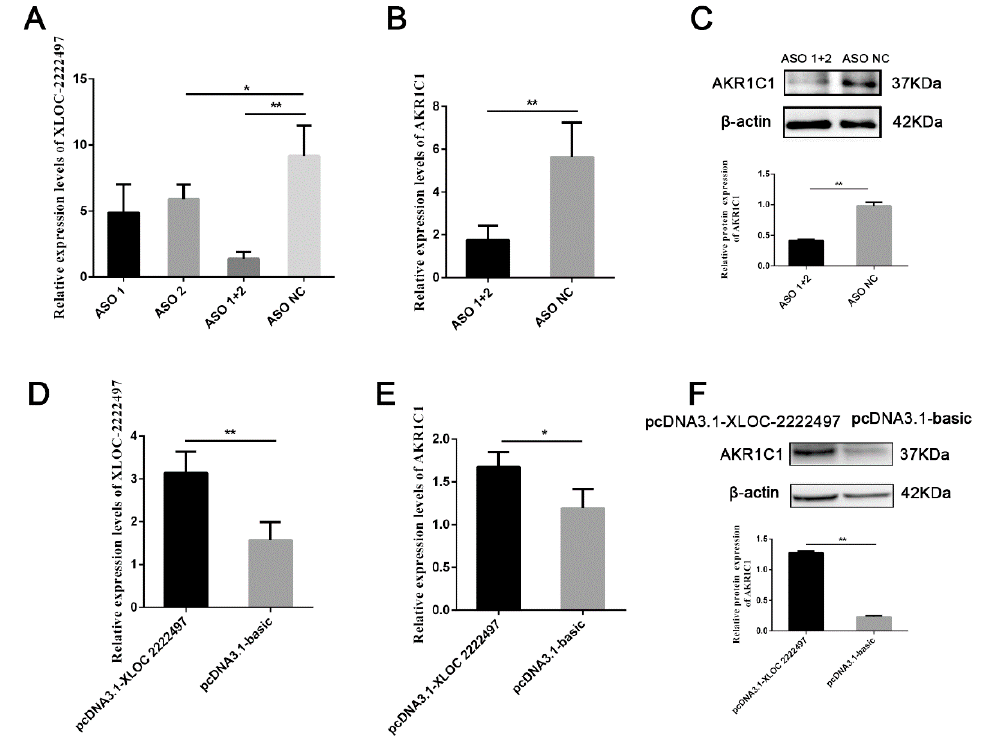
Figure 5. The regulation of XLOC-2222497 on AKR1C1 . ( A ) qRT-PCR results of antisense oligonucleotide (ASO) knockdown e ffi ciency detection. * represents p < 0.05. ** represents p < 0.01. ( B ) qRT-PCR results of AKR1C1 after the transfection of ASOs. ** represents p < 0.01. ( C ) Western blot results of AKR1C1 after the transfection of ASOs. Down diagram: quantification of Western blot results, ** represents p < 0.01. ( D ) qRT-PCR results of AKR1C1 overexpression e ffi ciency detection. ** represents p < 0.01. ( E ) qRT-PCR results of AKR1C1 after the transfection of pcDNA3.1–XLOC-2222497. * represents p < 0.05. ( F ) Western blot results of AKR1C1 after the transfection of pcDNA3.1–XLOC-2222497. Down diagram: quantification of Western blot results, ** represents p < 0.01.